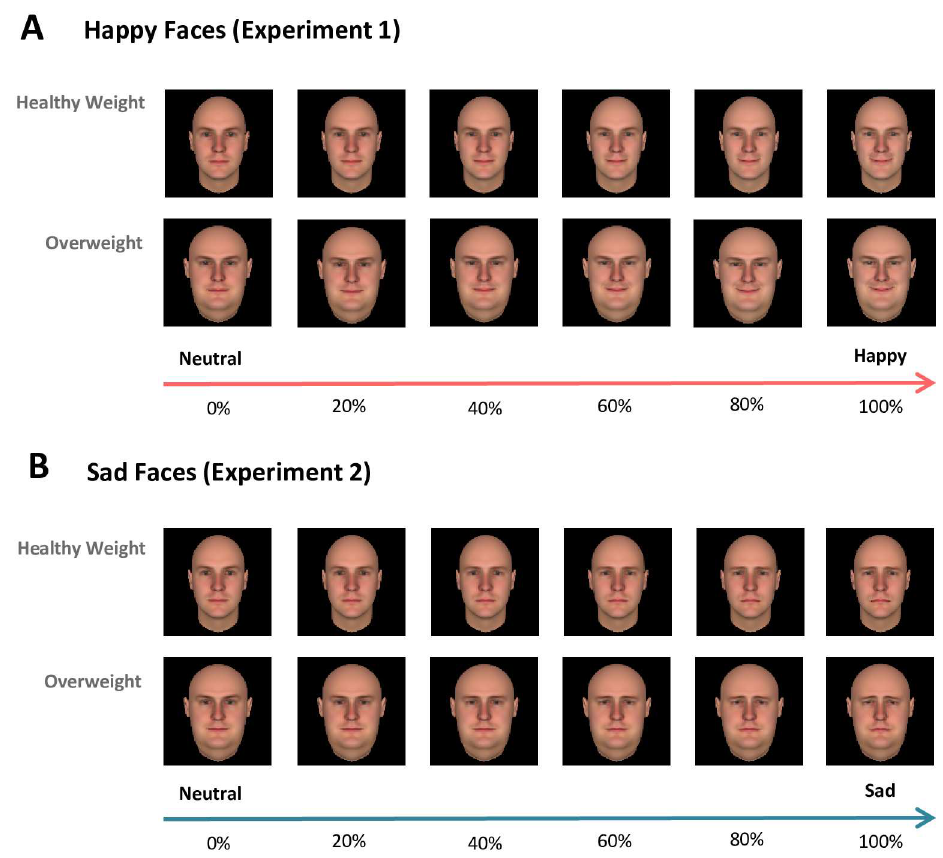
Fig 1. Experimental stimuli. A. Exemplar facial stimuli used for the neutral-happy judgment task. B. Exemplar facial stimuli used for the neutral-sad judgment task. All facial stimuli were computer- generatedand no actual faces were used in our study. A total of four computer-generatedidentities (two males and two females) were used in each experiment. Emotional expressionand bodyweightof facial stimuli were systematically manipulated by using a morphingsoftware. Faces have emotiongradientsrangingfrom 0% (neutral emotion)to 100% (full emotion; either happy or sad) by increments of 20%.